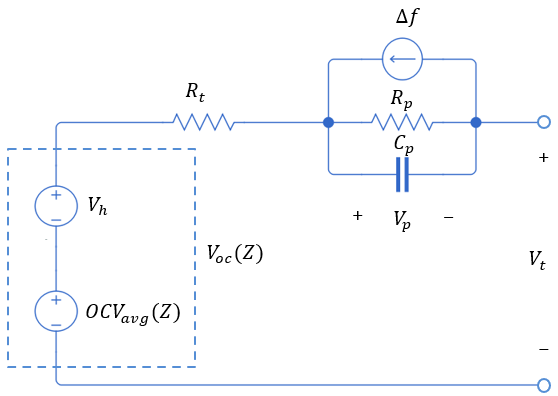
Figure 2. The first order hysteresis RC equivalent circuit model.